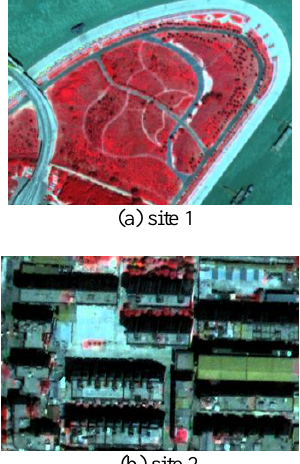
Figure 1. Quickbird color images of the study area